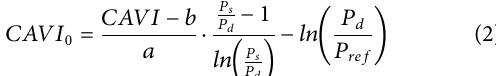
Frontiers in Physiology |